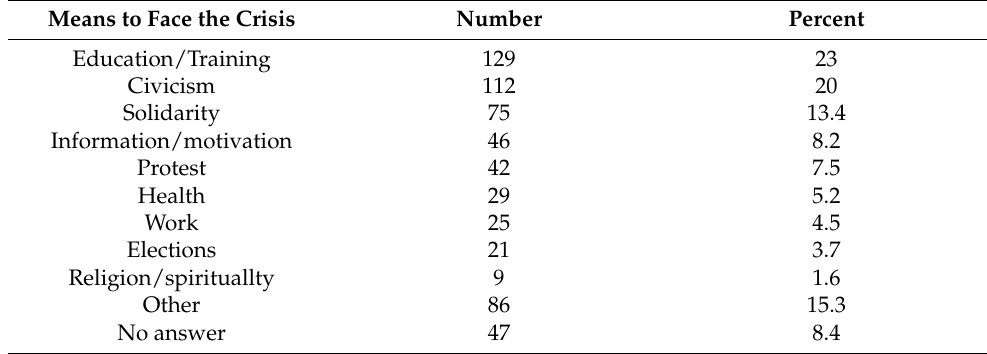
Table 6. Means to face the crisis according to Panamanian residents 1